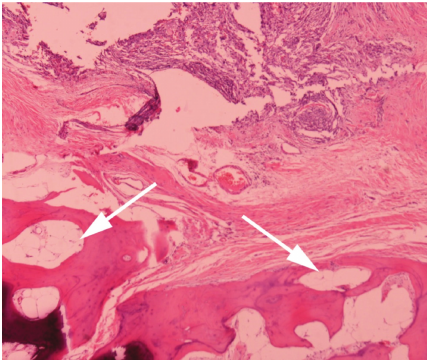
Figure 5: Presence of mature bone formation (white arrows) (H&E) × 400.